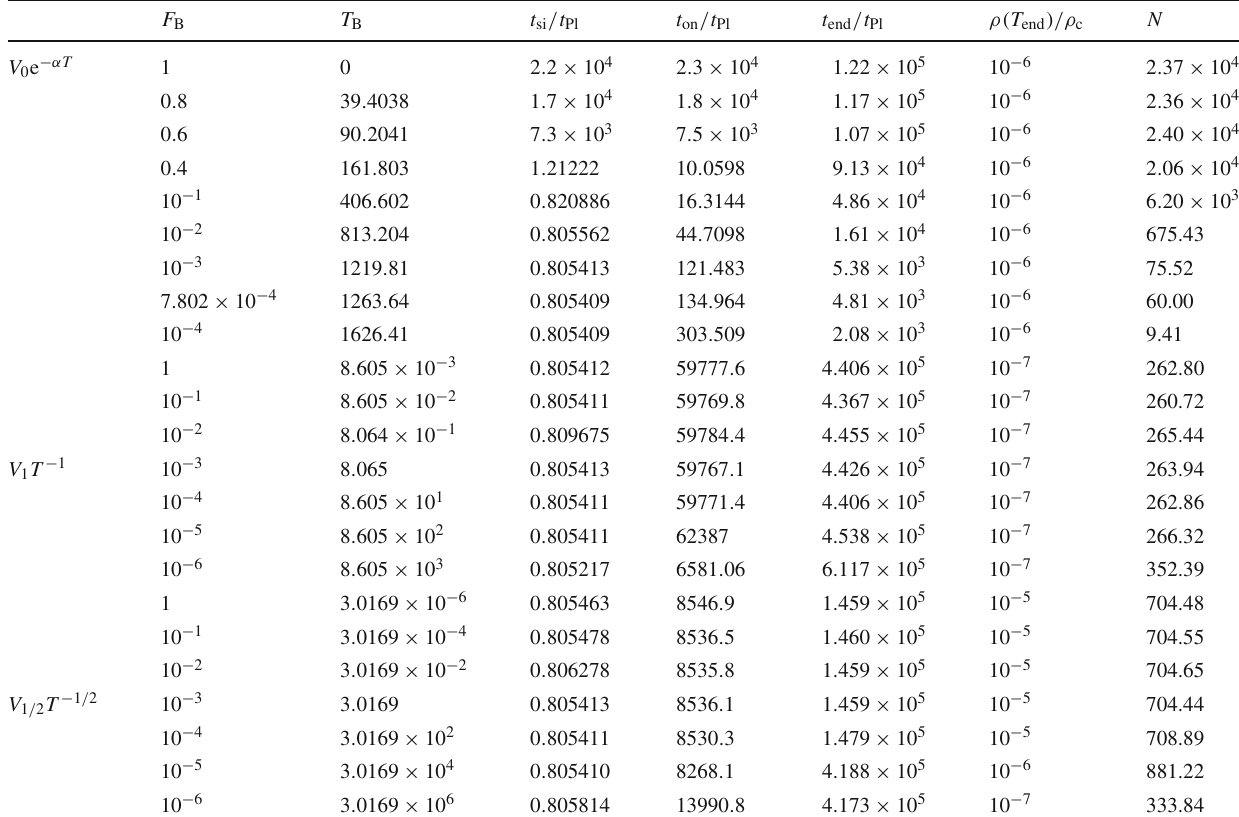
Fig. 1 Evolutions of H ,ω, V ( T ) , and ρ for an exponential potential. The initial conditions for plots I and II are shown in II. Plot III is of V ( T ) (solid) and ρ (dotted) for the initial conditions F B = 1 (red), F B = 0 . 8 (blue), F B = 0 . 6 (black), and F B = 0 . 1 (green) Table 1 Quantities involved in background evolution. The time t si is the end of super-inflation, and t on ( t end ) is the time of onset (end) of slow-roll inflation. The values of F B start from the PED case and approach the KED